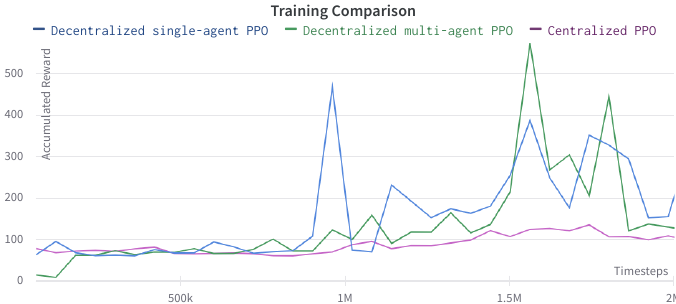
Figure 14. Comparison of accumulated reward for the centralized and decentralized PPO agents. Created with ❤ on Weights & Biases.